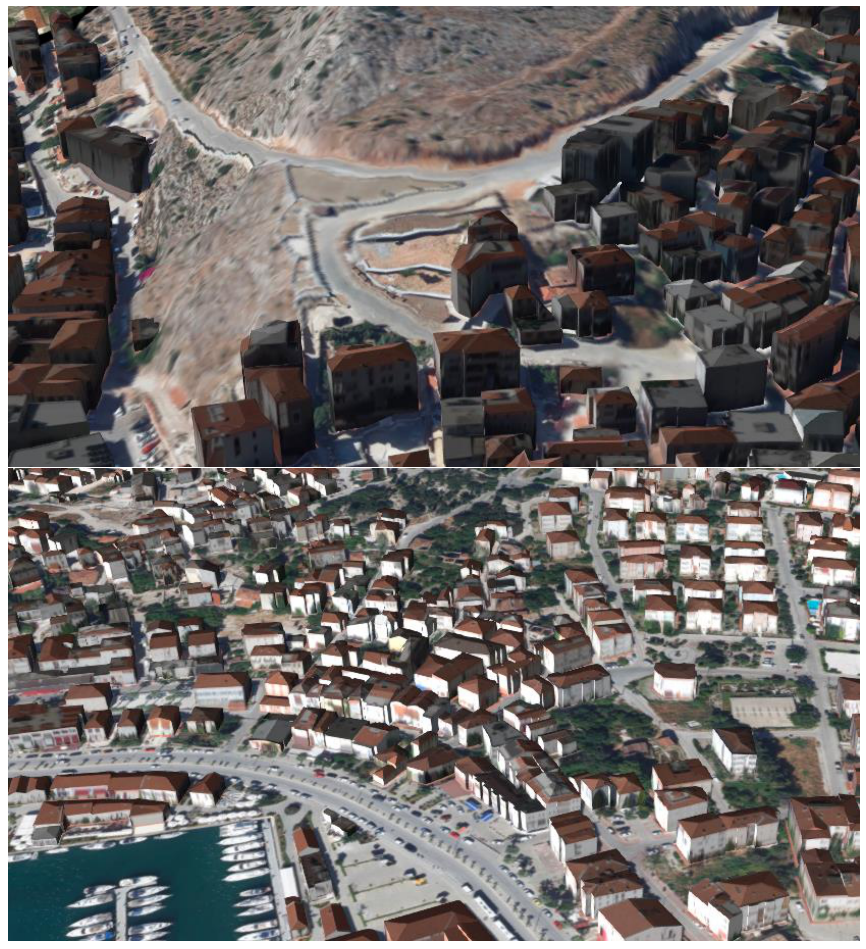
Figure 19. Different parts of the resulting 3D city model of Cesme.